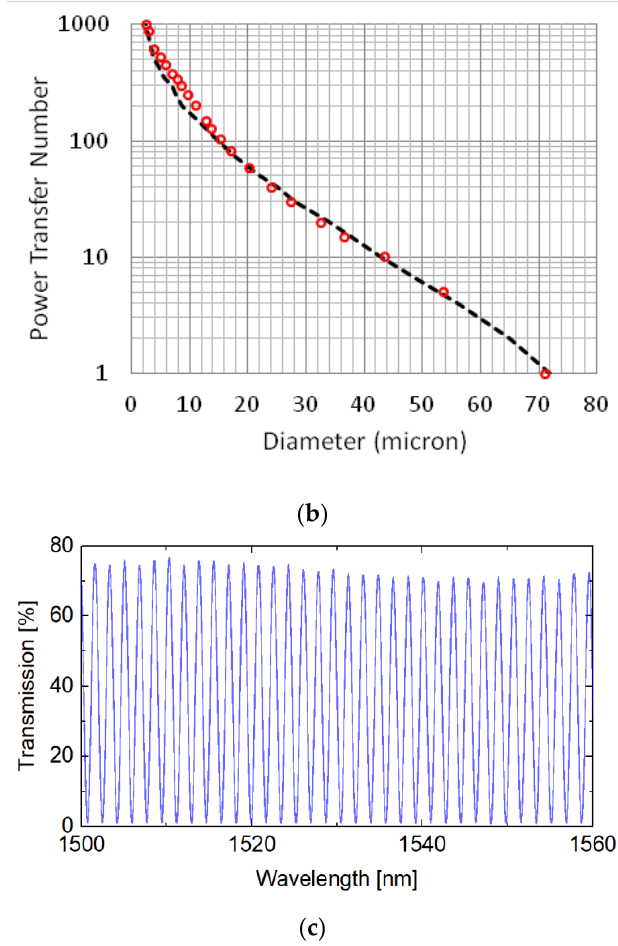
Figure 5. ( a ) Transmitted power recorded at λ 0 = 1.55 μm during taper fabrication for the first 65 oscillations. ( b ) PTN versus taper waist diameter. The experimental results are represented in red open circles, and the model simulation by black dashed line. According to the simulation, longer tapers ( L ~ 85 mm) result in PTN ~ 10 3 , 1.4 < FSR < 1.8 nm, and 4 < ρ waist < 6 µm. ( c ) Spectral response obtained from a taper 76 mm long, FSR = 1.7 nm, taper waist diameter ~5.6 µm, and insertion loss ~1.1 dB.